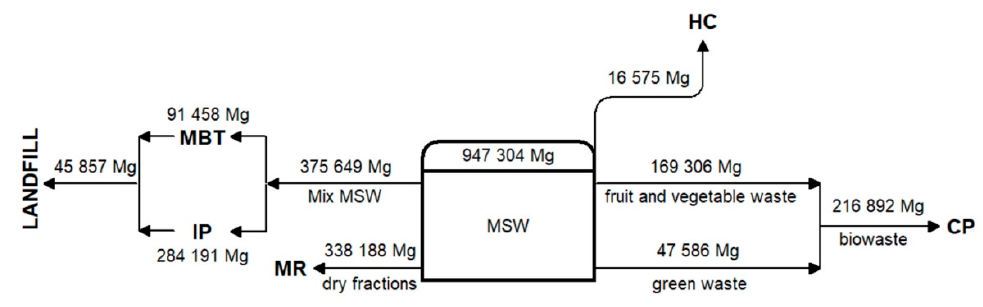
Figure 7. MFA for TS-I-S3, prediction for 2035.